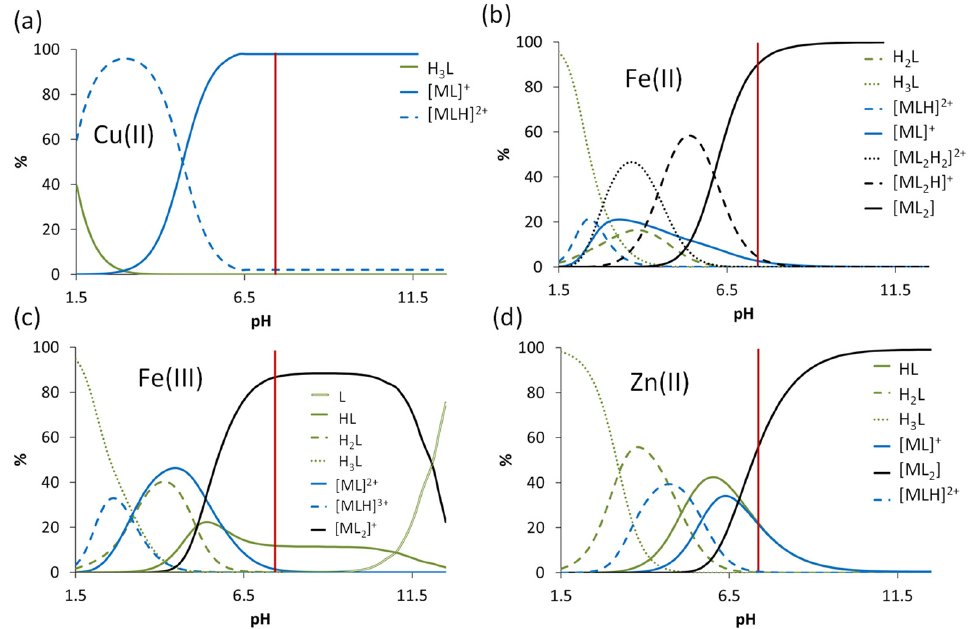
Figure 6. Calculated concentration distribution curves for ( a ) Cu(II):COTI-2 = 1:1, ( b ) Fe(II):COTI-2, ( c ) Fe(III):COTI-2 = 1:2, and ( d ) Zn(II):COTI-2 = 1:2 system ( c L = c Cu(II) = 1 µM, c Fe(II) = c Fe(II) = c Zn(II) = 0.5 µM, 30% ( v/v ) DMSO/H 2 O, T = 25 °C, and I = 0.10 M (KCl)). The red lines indicate pH 7.4.